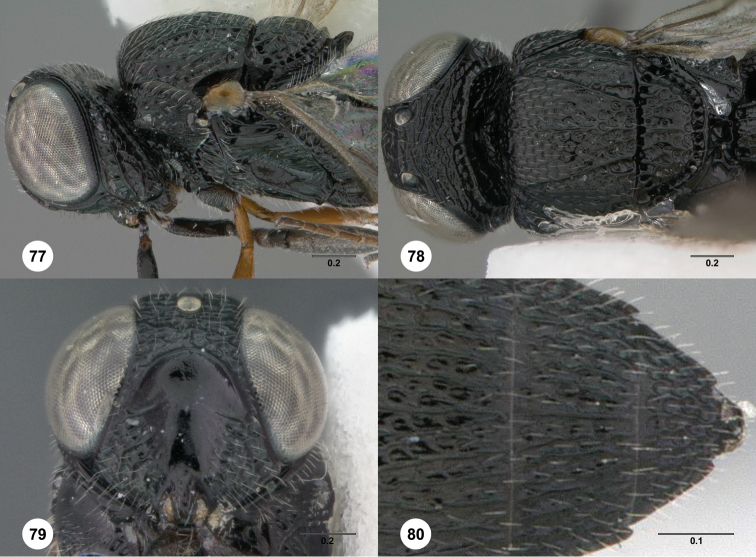
Oxyscelio cuspidis sp. n., holotype female (OSUC 439574) 77 Head and mesosoma, lateral view 78 Head and mesosoma, dorsal view 79 Head, anterior view 80 Metasoma, dorsal view. Morphbank42